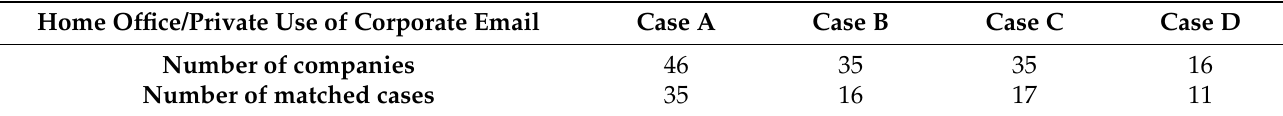
Table 4. Relation between enabled home office, private use of corporate email and ransomware